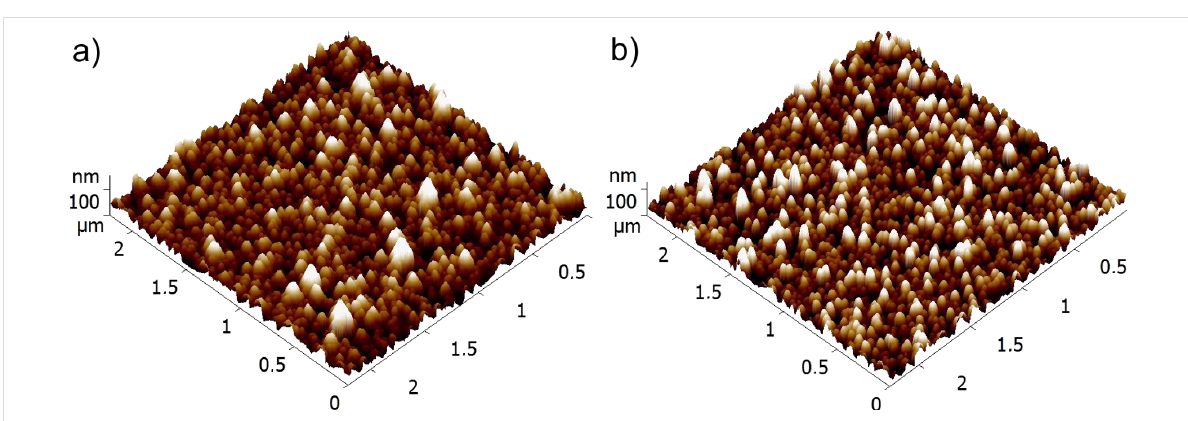
Figure 2: AFM images of sample type 2 (a) after Ti cluster deposition and annealing (120 °C for 5 min in ambient atmosphere) and (b) after use in antibacterial experiment and washing out the cells (5th cycle).